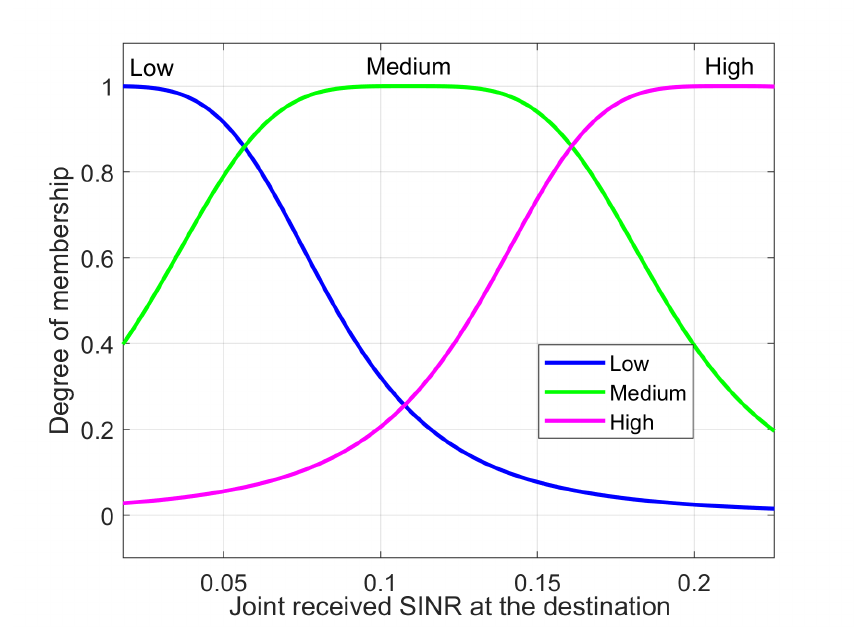
Figure 5. Input (joint received SINR at the destination) membership